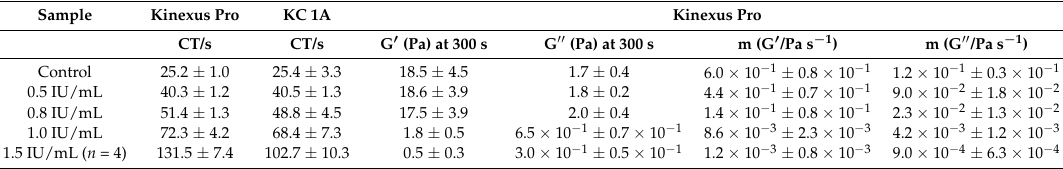
Table 1. Comparative data of Kinexus Pro and KC 1A for the measurement of the prothrombin time (PT) ( n = 10). Citrated blood without and with various concentrations of heparin was activated by Thromborel. Summary of the clotting time (CT), elastic (G (cid:48) ) and viscous (G (cid:48)(cid:48) ) shear moduli at 300 s and linear slopes (m (G (cid:48) ) and m (G (cid:48)(cid:48) )). Sample Kinexus Pro KC 1A Kinexus Pro CT/s CT/s G (cid:48) (Pa) at 300 s G (cid:48)(cid:48) (Pa) at 300 s m (G (cid:48) /Pa s − 1 ) m (G (cid:48)(cid:48) /Pa s − 1 )